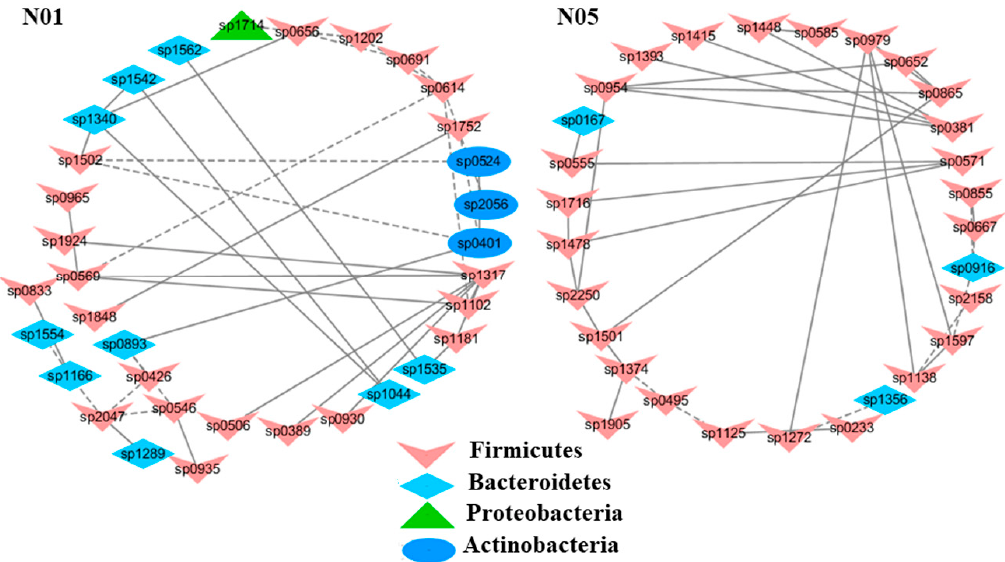
Figure 2. Select modules displaying a strong correlation with blood urea nitrogen contents (BUN) in healthy mice. The interactions among different nodes (OTUs) within a module were shown: solid line: positive correlation; dashed line: negative correlation. The color of each node (OTU) indicated the phylum that this OTU was assigned to. The detailed annotation of each OTU node can be found in Table S3.